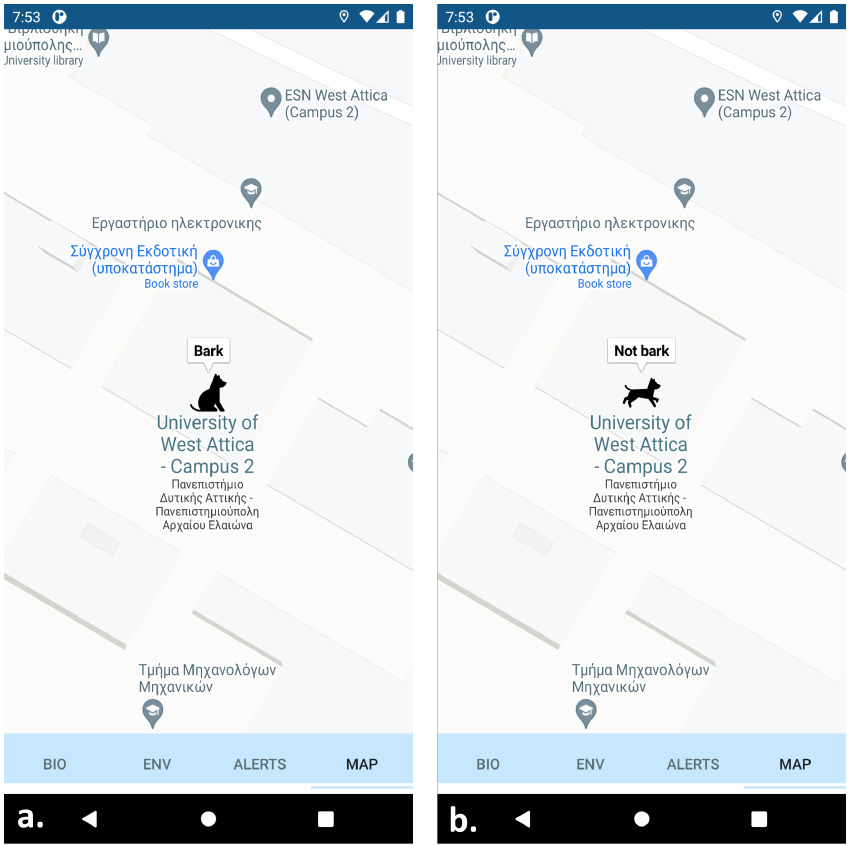
Figure 4. Developed smartphone application displaying SaR dog behavior: ( a ) canine is not moving and barks; ( b ) canine is moving and does not